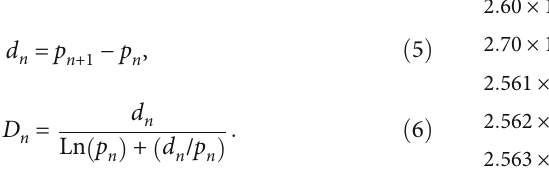
Figure 3: Nearest Neighbor Spacing Distribution (NNSD) for (a) the 25 million primes, (b) the 26 million primes, and (c) the 27 million primes with the best fi t calculated using the inverse χ 2 distribution Equation (3) and the Brody distribution Equation (7) including the average absolute deviation calculations Δ . Table 1: The fi t parameters and absolute average deviation for the 25 th to 27 th million prime while the last three rows for 10 4 primes around from 2 : 561 × 10 7 to 2 : 563 × 10 7 .